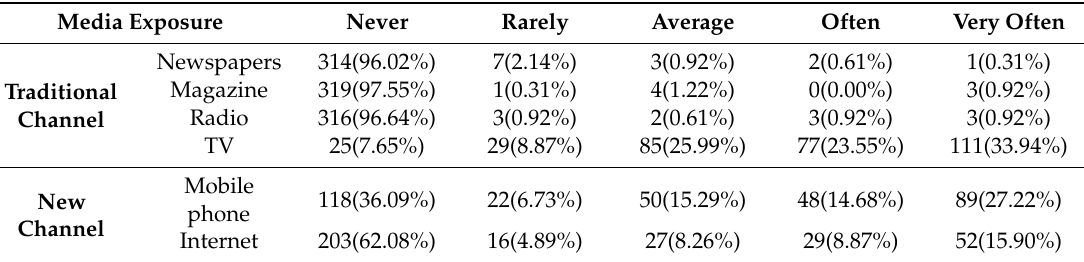
Table 2. Distribution of media exposure frequency.